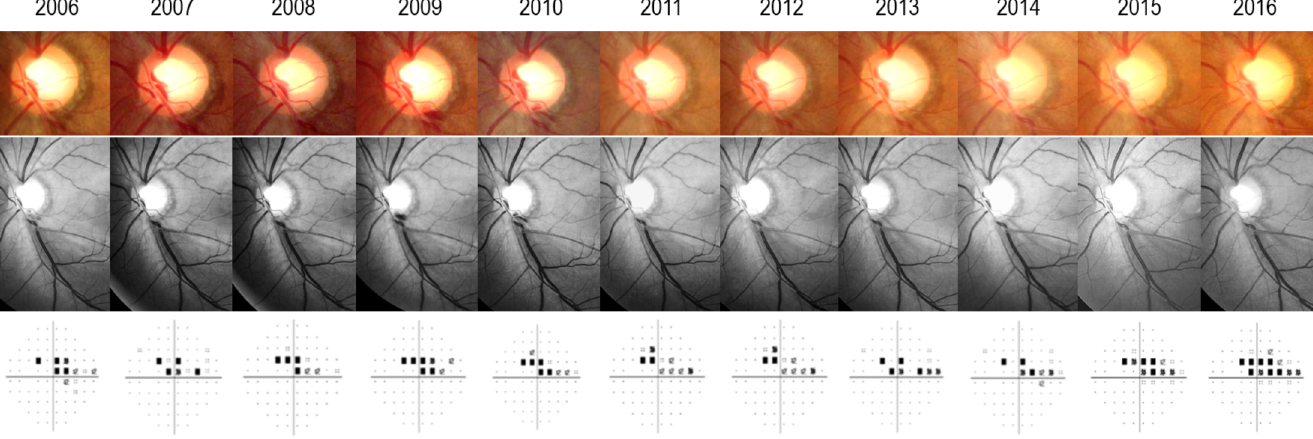
PLOS ONE | https://doi.org/10.1371/journal.pone.0189706 December18,